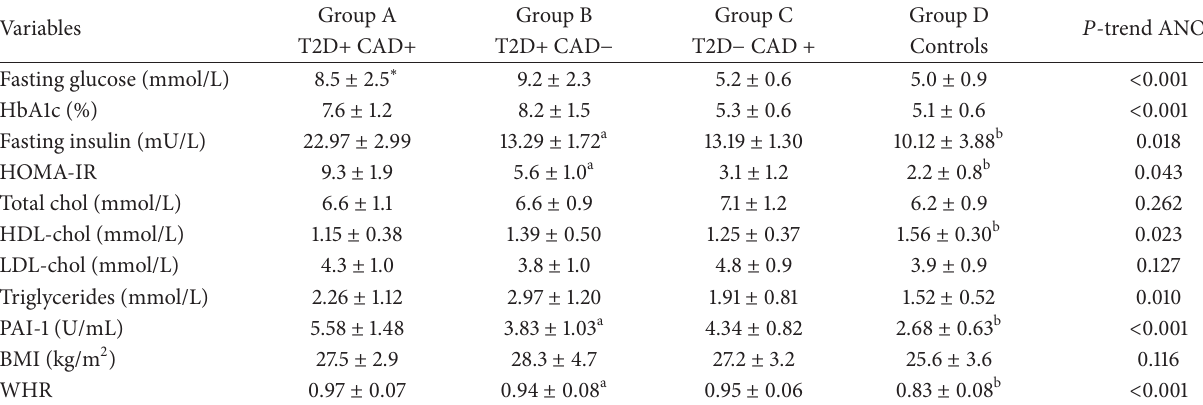
Table 2: Metabolic and anthropometric